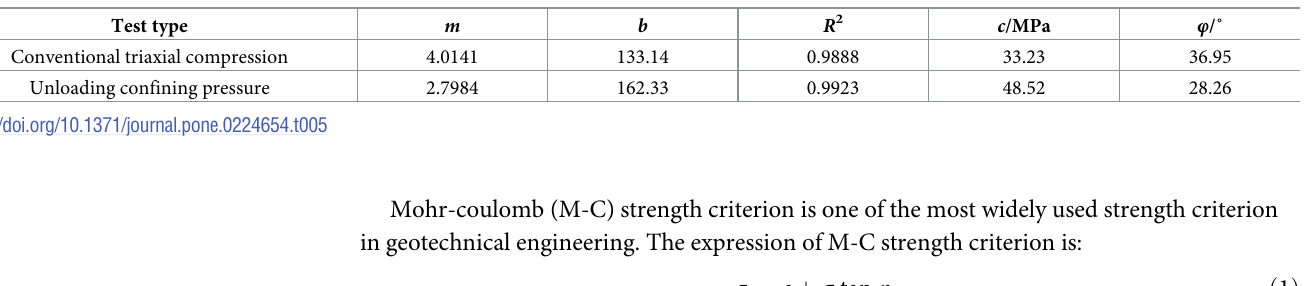
Table 5. Shear strength parameters of shale sample under different stress